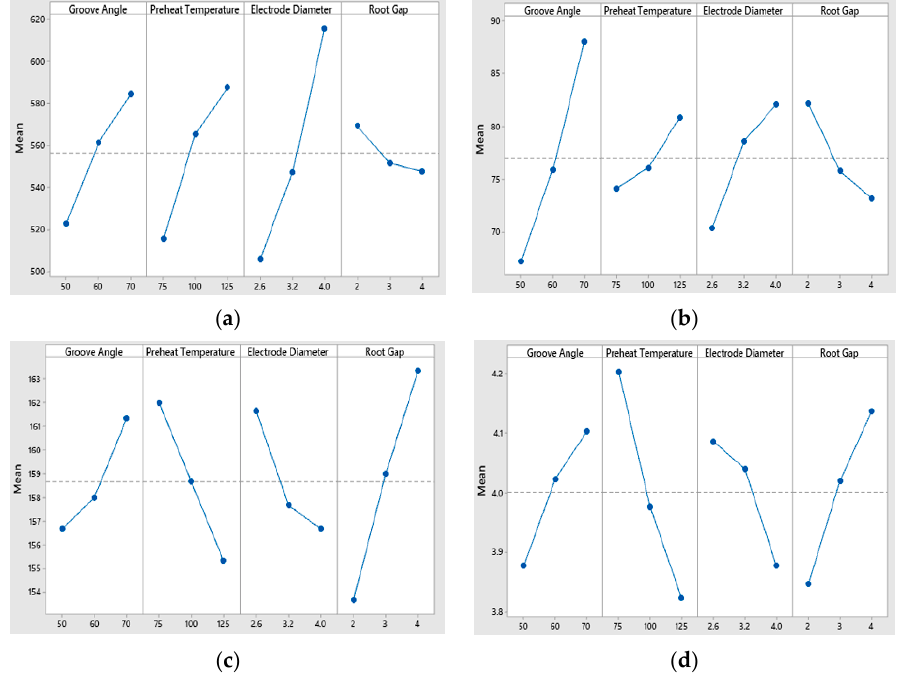
Figure 7. Main effect plot of means for ( a ) tensile strength; ( b ) impact energy; ( c ) hardness; ( d ) angular distortion.